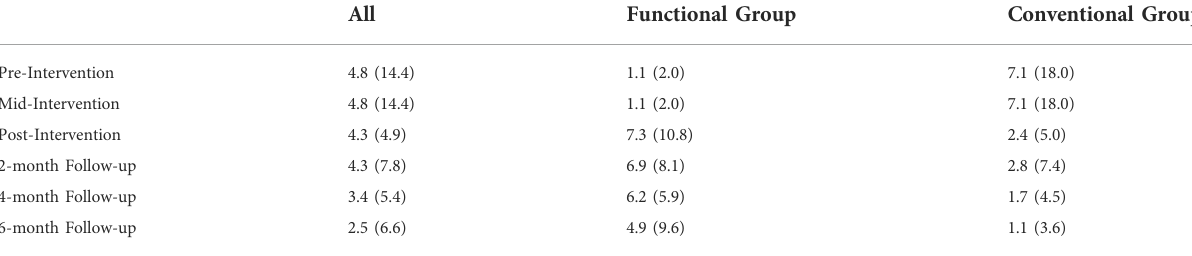
All Functional Group Conventional